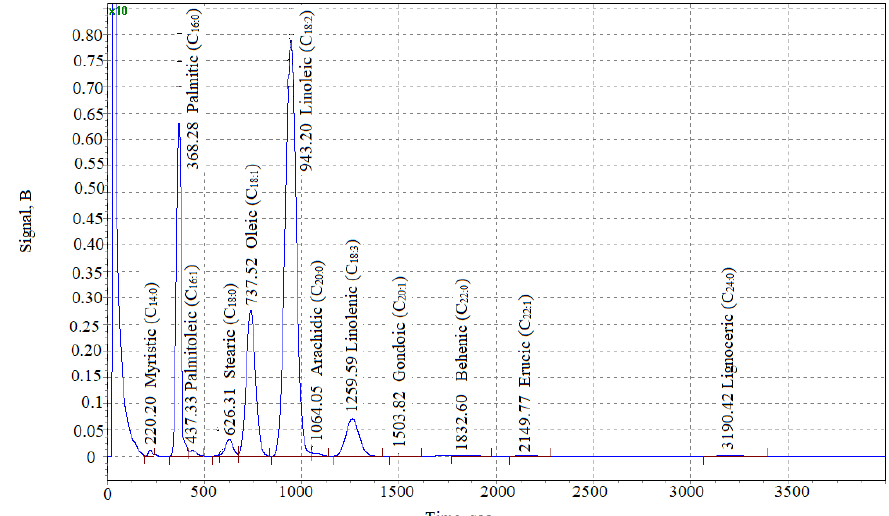
Fig. 2. Gas chromatogram of fatty acid composition in a lipophilic fraction of barley grains (Shedevr